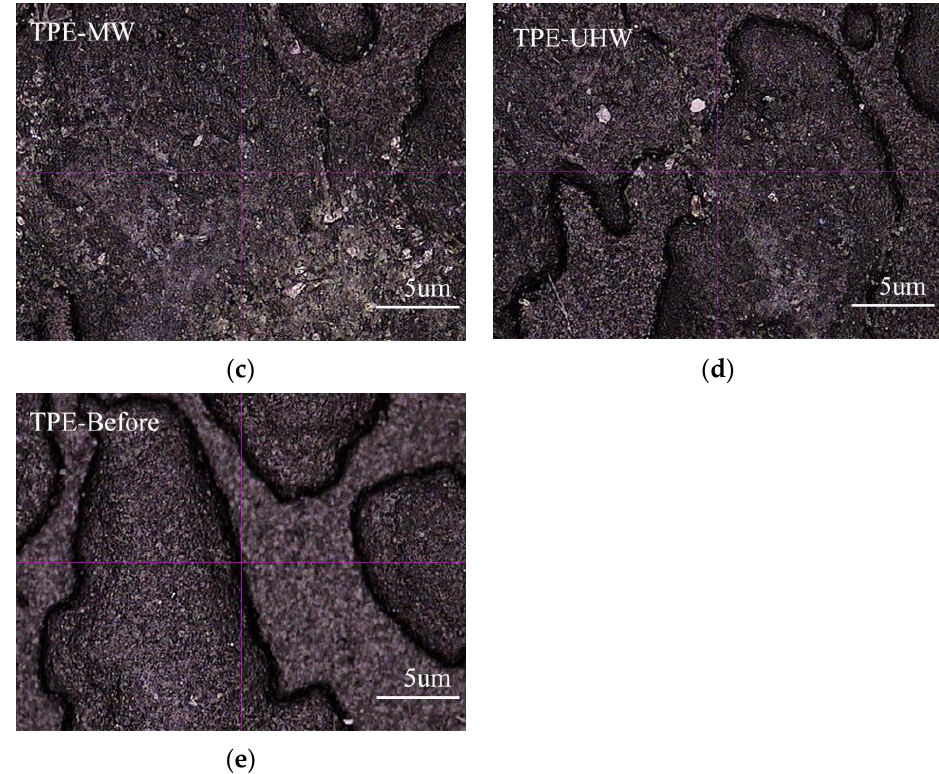
Figure 3. 40 times magnification of the wear scratch of samples with similar structures and various molecular weight SEBS after Taber test. ( a ) TPE-LW; ( b ) TPE-MW; ( c ) TPE-HW; ( d ) TPE-UHW; ( e ) the magnified view before Taber abrasion test.